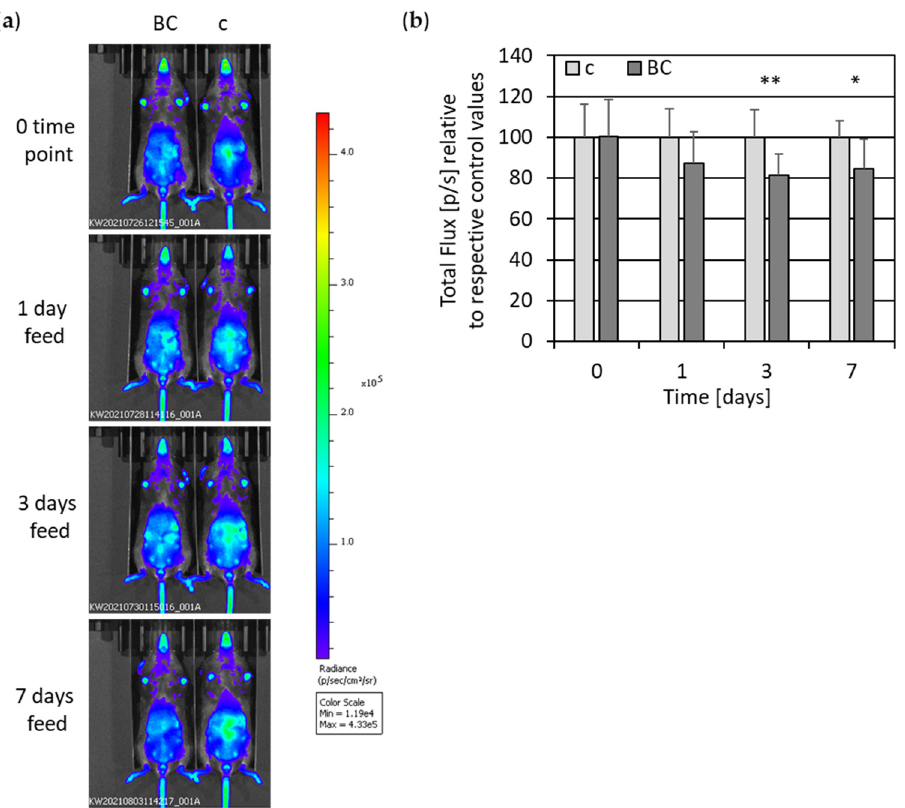
Figure 8. NF- κ B induction measured by in vivo luciferase activity of control- vs. BC-fed mice. ( a ) Representative pictures are shown as bioluminescent images with artificial colors in NF- κ B-luciferase reporter mice. Bioluminescent images were measured 15 min after i.p. injection of the substrate D-luciferin. In vivo imaging of luciferase activity is shown before (0 time point) and upon 1, 3 and 7 days’ feeding. Animals received either control food (c) or food supplemented with 15 % bread crust (BC). ( b ) Quantification of in vivo imaging of luciferase activity in NF- κ B-luciferase reporter mice. Photon emission was determined by IVIS (total Flux [p/s]) and is shown as mean with standard deviation relative to respective control values before (0 time point) and upon 1, 3 and 7 days’ feeding ( n = 18; c = 7; BC = 11). * p ≤ 0.05; ** p ≤ 0.01 ( t test) BCE vs. control-fed